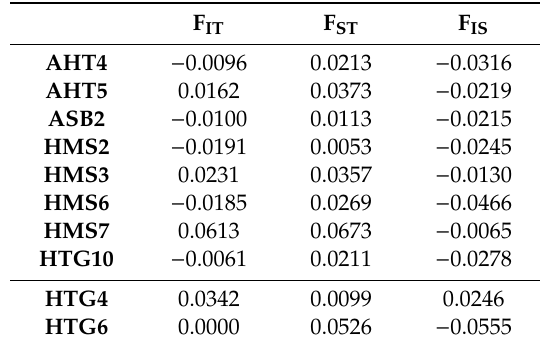
Table 2. Genetic structure coefficient based on F-statistics: inbreeding coefficient (F IT ), coefficient of differentiation (F ST ) and mean inbreeding index value (F IS ) for each locus.